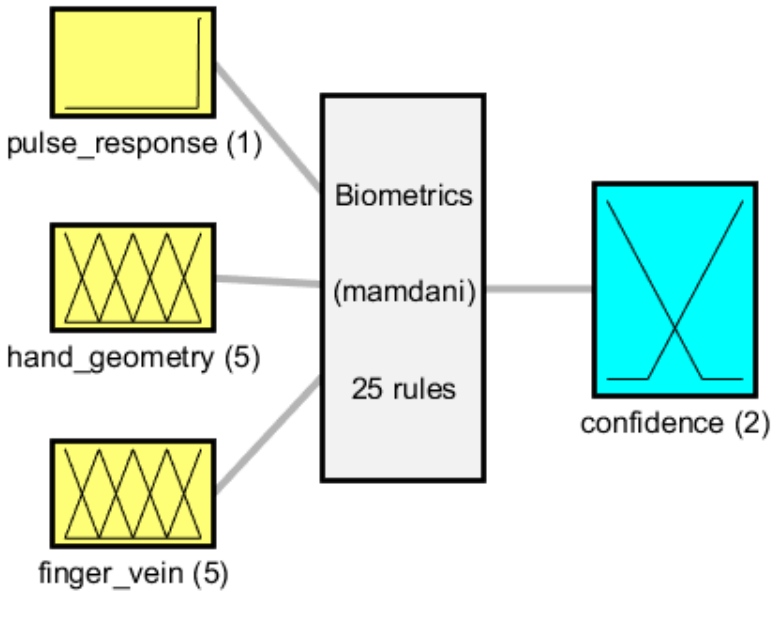
Figure 6. Fuzzy biometric fusion system.